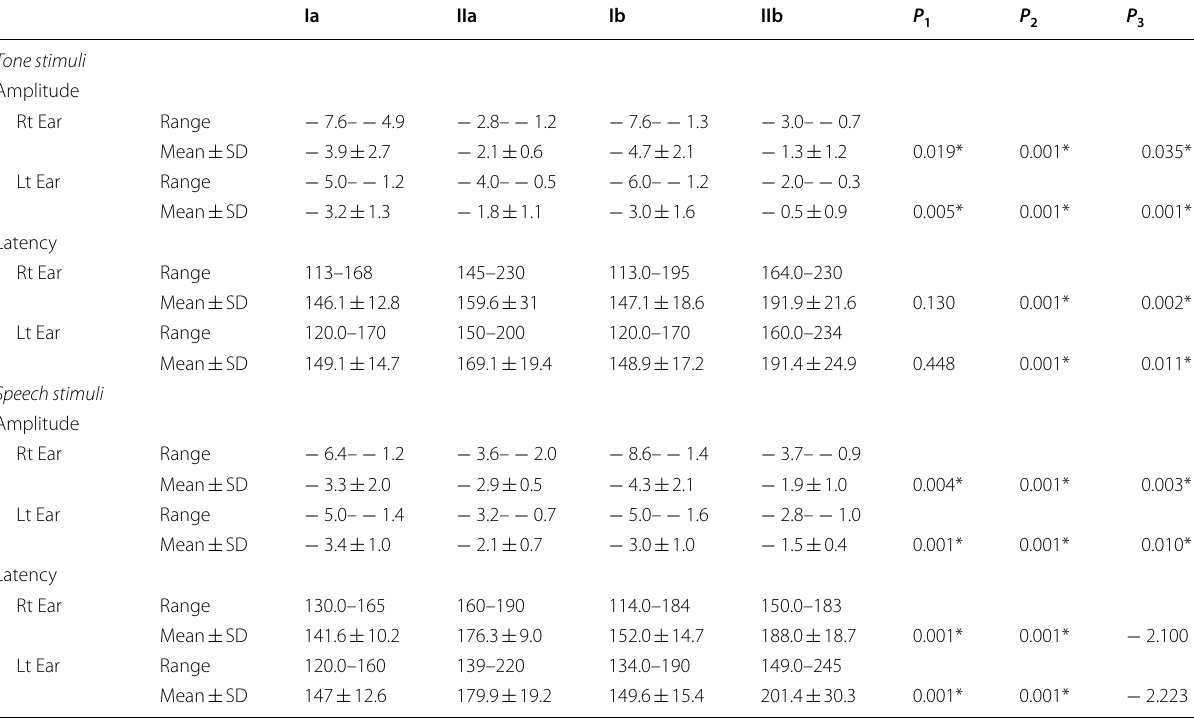
Table 2 Comparison of MMN responses (using both tone and speech stimuli) between different study